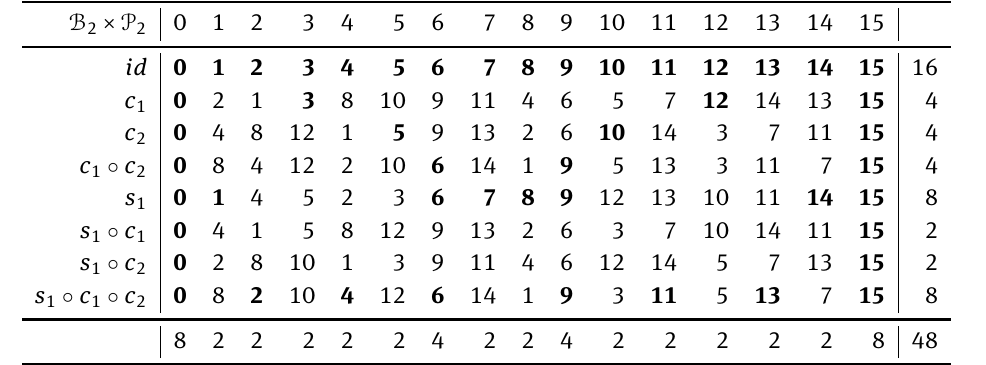
Table 6: The action of B 3 on the sixteen 0/1 -polytopes in I 2 .